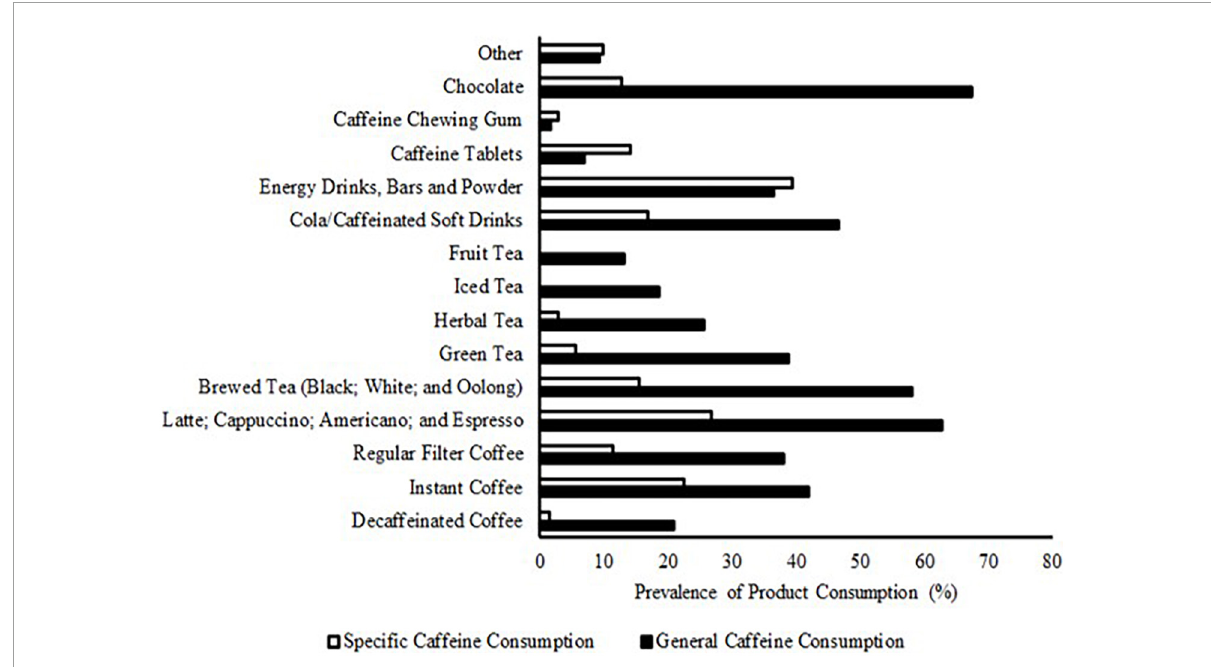
FIGURE1 Prevalence of caffeinated product consumption (%) within British Fencing athletes during a typical 24-h period outside of fencing training/competition (general caffeine consumption) and before (1-h preceding)/during fencing training and/or competition (specific caffeine consumption).